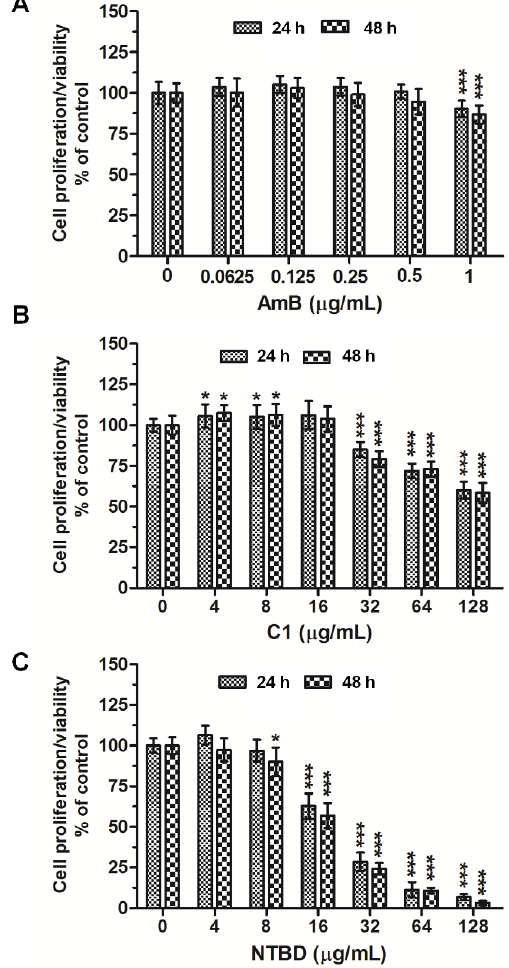
Figure 1. The impact of AmB and thiadiazols C1 and NTBD on the viability of RPTEC cells. Cells were incubated with or without increased concentrations of AmB ( A ), C1 ( B ), or NTBD ( C ) for 24/48 h, and the cell viability/mitochondrial dehydrogenase activity was assessed by MTT assay. Results were expressed as % viability of cells as compared to vehicle (DMSO) control (mean ± SD). Values are significantly different from control, if p < 0.05 *, p < 0.001 ***, using one-way ANOVA test. Results are shown as a representative of three independent